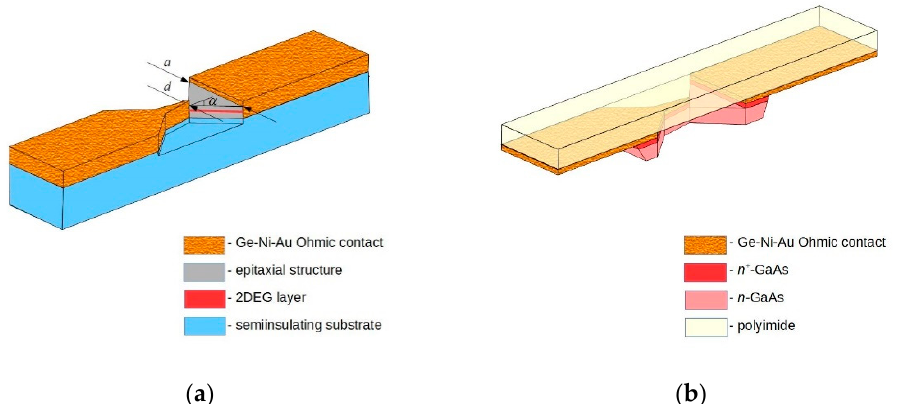
Figure 1. Schematic view of a planar, asymmetrically necked microwave diode on the base of ( a ) an epitaxial semiconductor layer situated on a semi-insulating substrate, and ( b ) bulky GaAs “glued” onto a polyimide film. Vertical dimensions are not to scale.